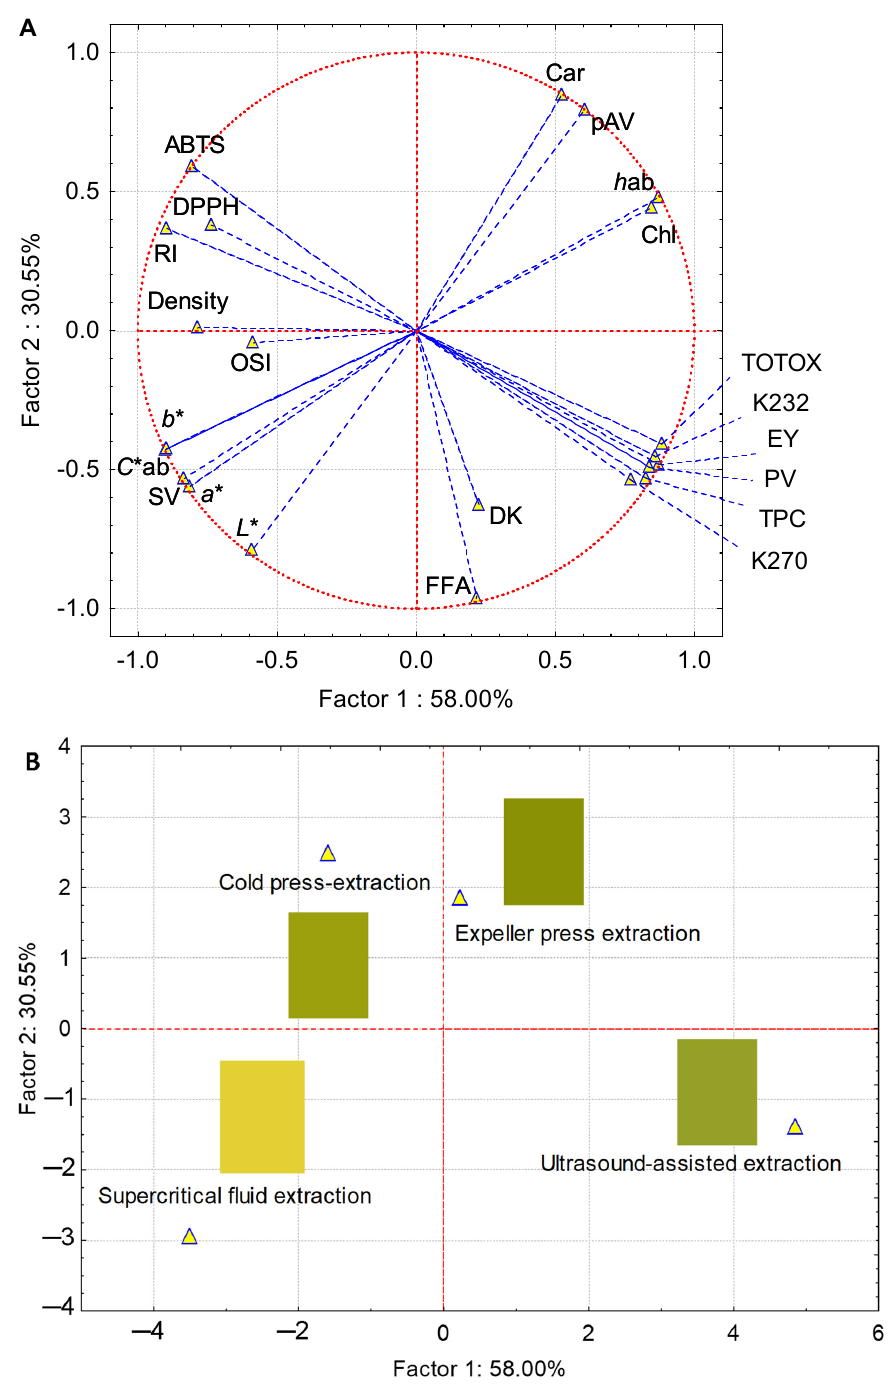
Figure 4. PCA of the sinami oils that were obtained using CPE, EPE, UAE and SFE, based on the physicochemical properties, total polyphenol content and antioxidant activity: ( A ) PCA score plot with PC1 and PC2, based on the dataset of 22 different variables of plant pigments (Car, carotenoids; Chl, chlorophylls), chromatic parameters ( L *; a *; b *; C *ab; h ab), physicochemical properties (EY, extraction yield; density; RI, refractive index; K232 and K270, dienes and trienes; ∆ K, extinction coefficient variation; FFA, free fatty acidity; PV, peroxide value; pAV, p-anisidine value; TOTOX, total oxidation value; SV, saponification value; OSI, oxidative stability index) and antioxidant activity (DPPH; ABTS; TPC, total polyphenol content); ( B ) PCA classification for the same sinami